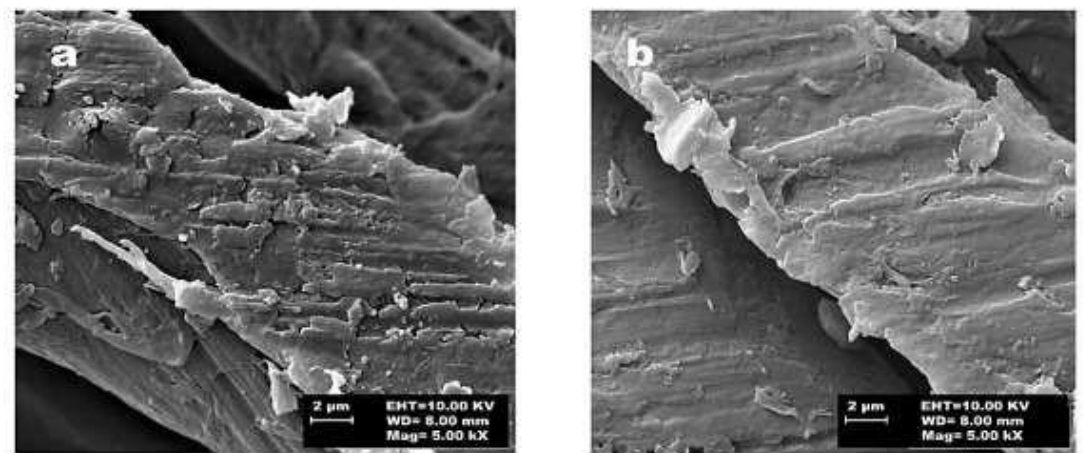
Fig. 5. Fibre deformation and wear in (a) weft and (b) warp directions.